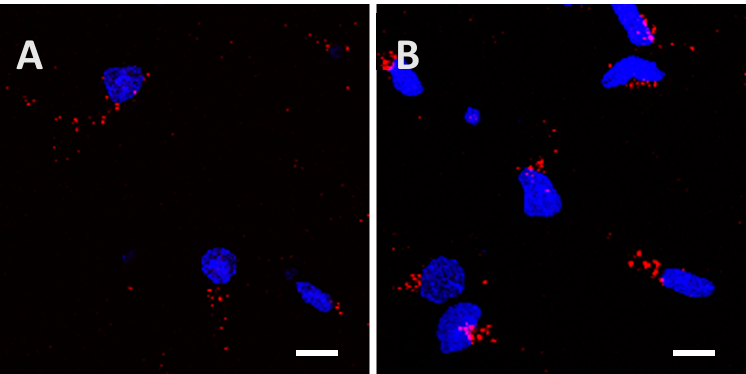
Figure A6. Low phosphorylated (15 μ g; A ) and highly phosphorylated Tau proteins (1.5 μ g; B ) were visible inside cortical cells after 24 h of incubation even when a washing with 0.05% of trypsin for 1 min was performed. Trypsin was used to remove potential proteins attached to the extracellular matrix or the cytoplasmic membrane. Scale bars, 10 μ m.